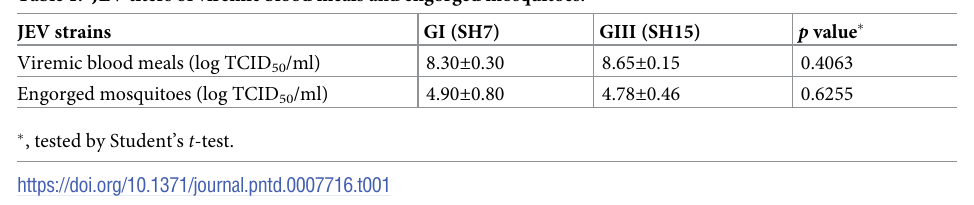
Table 1. JEV titers of viremic blood meals and engorged